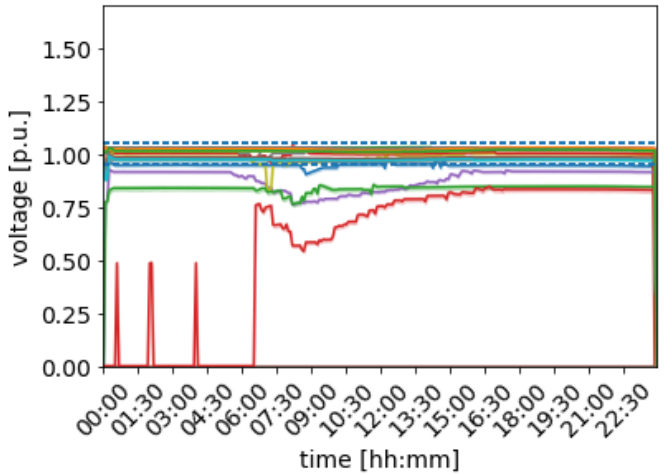
Figure 12. Scenario 2 distribution feeder nodal voltage mean and 95% range for all nodes, plotted by substation feeder group. substation feeder